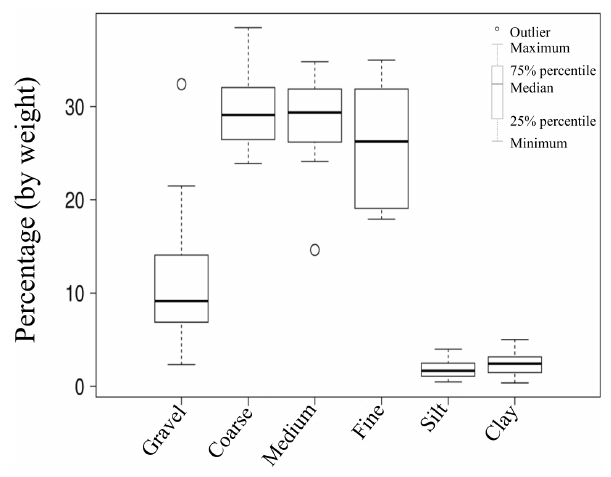
Figure 1. Boxplots showing the interquartile range (first quartile, median and third quartile) of the sediment data. Whiskers: the values that extend to 1.5 times the interquartile range. When there are no outliers the whiskers show the maximum and